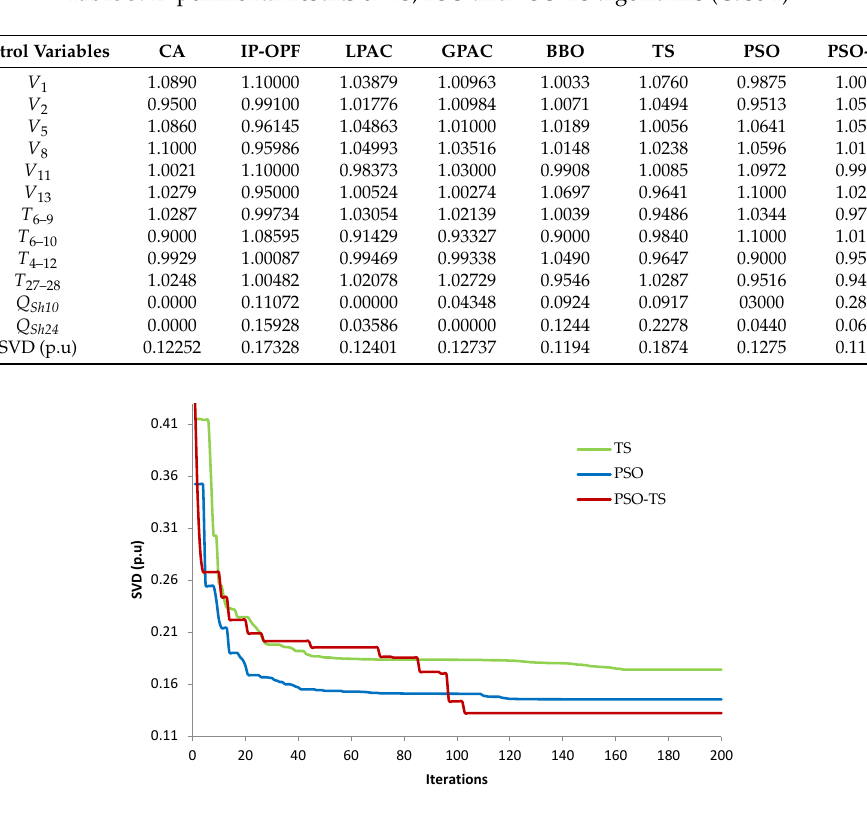
Table 3. Experimental results of TS, PSO and PSO-TS algorithms (Case 1).